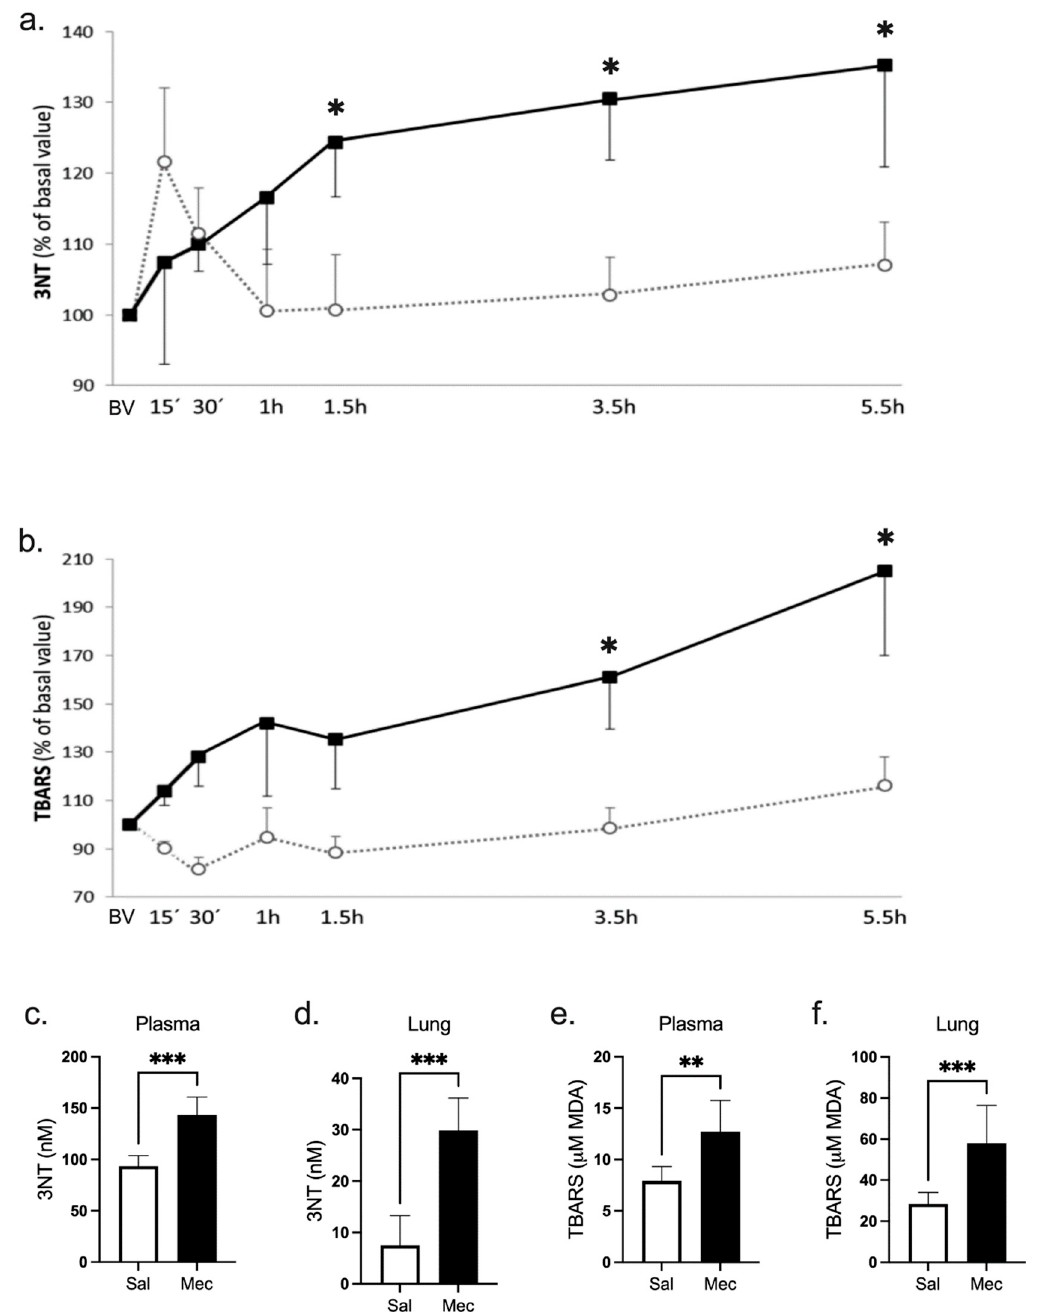
Figure 1. Nitrotyrosine and TBARS Production. ( a ) Nitrotyrosine levels (3NT, nM) and ( b ) reactive substances with thiobarbituric acid reactive substances (TBARS in µ M MDA) during experiment; 3NT and TBARS in final plasma ( c , e ) and in lung tissue ( d , f ) in the saline group (open circles) and the meconium group (closed squares). Statistical comparisons for Mec vs. Sal * p < 0.05, ** p < 0.01, *** p <